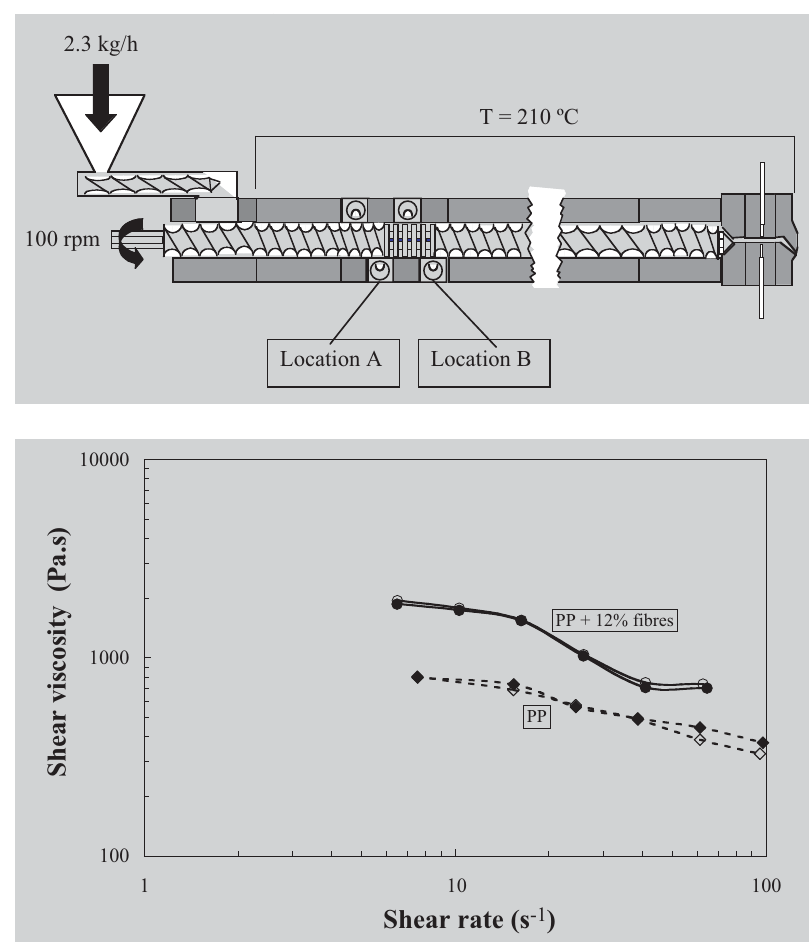
Figure 6 (above): Extruder layout and on-line measurements locations for the study on fibre degradation upon compounding of thermoplastic/short fibre composites. Figure 7 (below): Shear viscosity at beginning (full symbols) and end (open symbols) of mixing section, for the same study of Figure